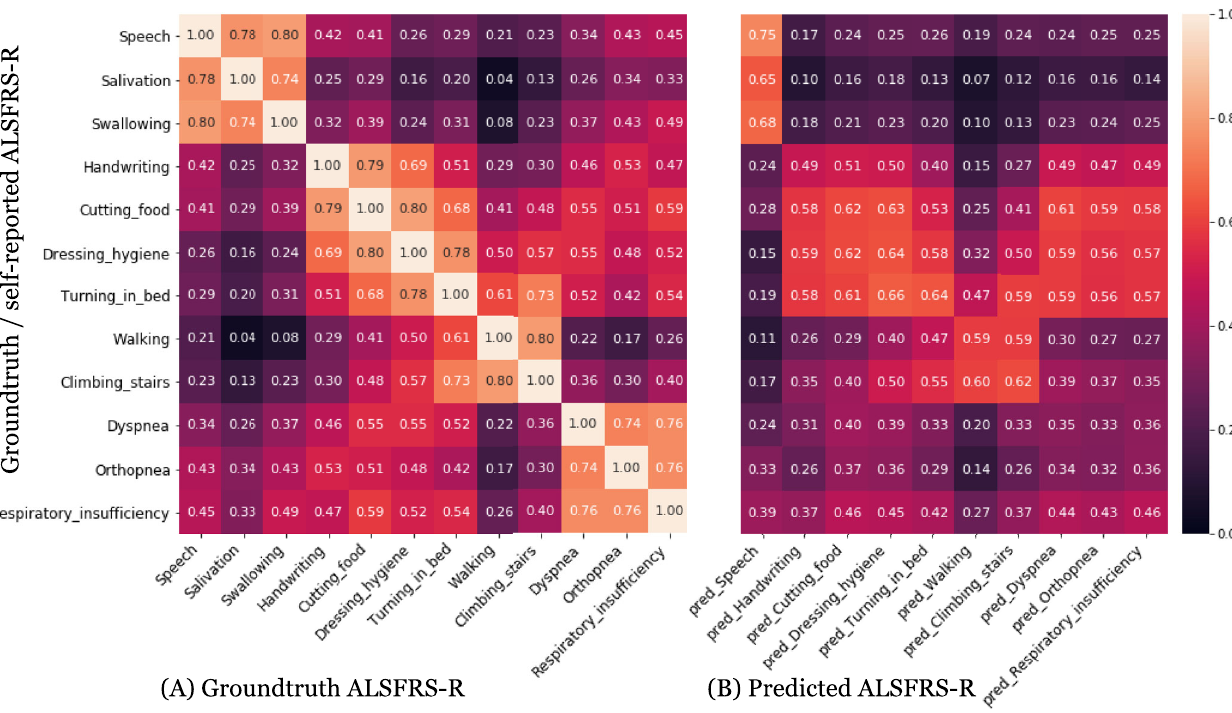
Fig. 1 Correlations between ALSFRS-R subscores and ML-predicted ALSFRS subscores. Correlation between ground-truth ( y -axis) ALSFRS-R scores with A Groundtruth ALSFRS-R and B ML-predicted ALSFRS-R scores ( x -axis) on the full test set of 109 participants. A There is a strong correlation between ALSFRS-R scores for speech, salivation, and swallowing. We also observed correlations between other sets of limb-related functions, speci fi cally, handwriting, cutting food, dressing hygiene and turning in bed, and then between walking, and climbing stairs, and the respiratory-related functions dyspnea, orthopnea, and respiratory insuf fi ciency. B We observed that the predicted ALSFRS-R for speech (based on the voice model) is most correlated with groundtruth speech ALSFRS-R followed by strong correlations with salivation and